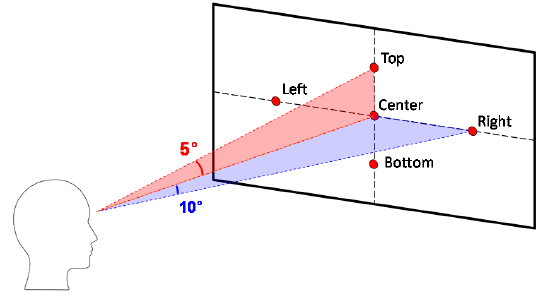
Figure 3. Five gaze positions used in the experiment.